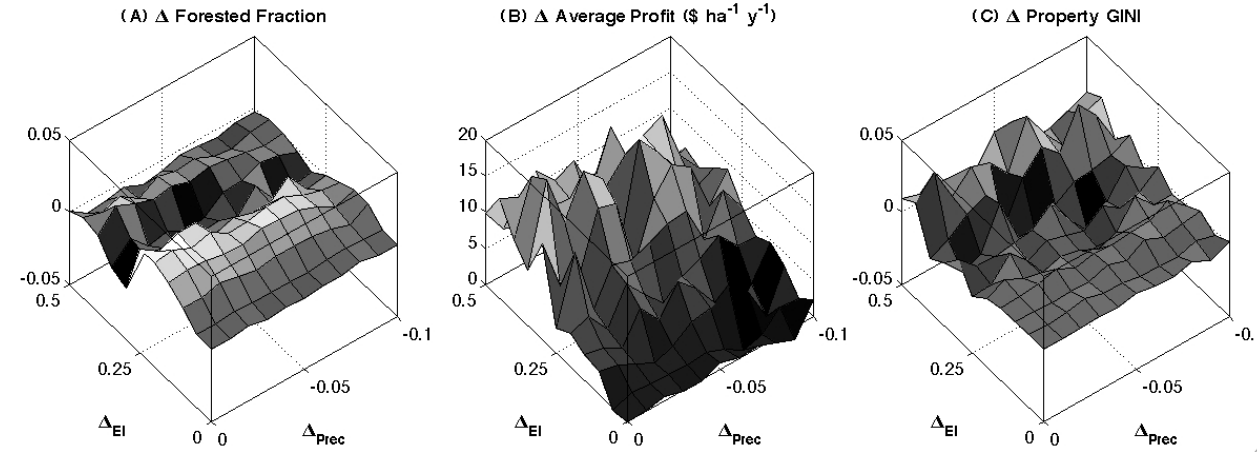
Fig. 5. Response surfaces for the differences between Policy Scenarios 1 and 2, given as (Outcome in Policy 2 – Outcome in Policy 1), for Rancher Scenario 1 (low networking, low size effect). (A) Average forested fraction across the landscape; (B) Average profit per hectare of property per year; (C) Level of land aggregation measured by the property GINI coefficient. Response surfaces for Rancher Scenarios 1-4 are shown in Appendix